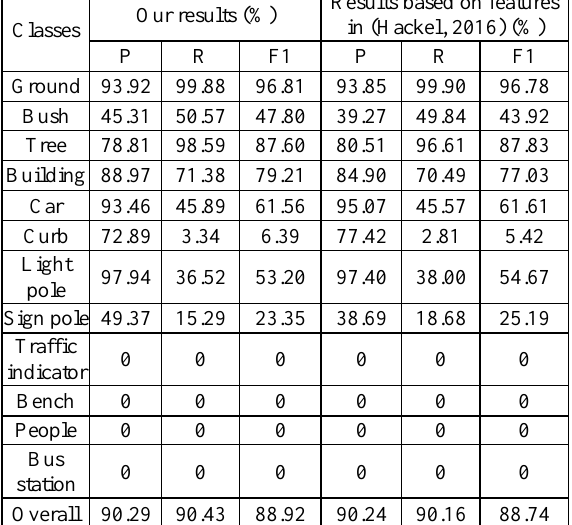
Table 2. Quantitative results of testing on mobile LiDAR point